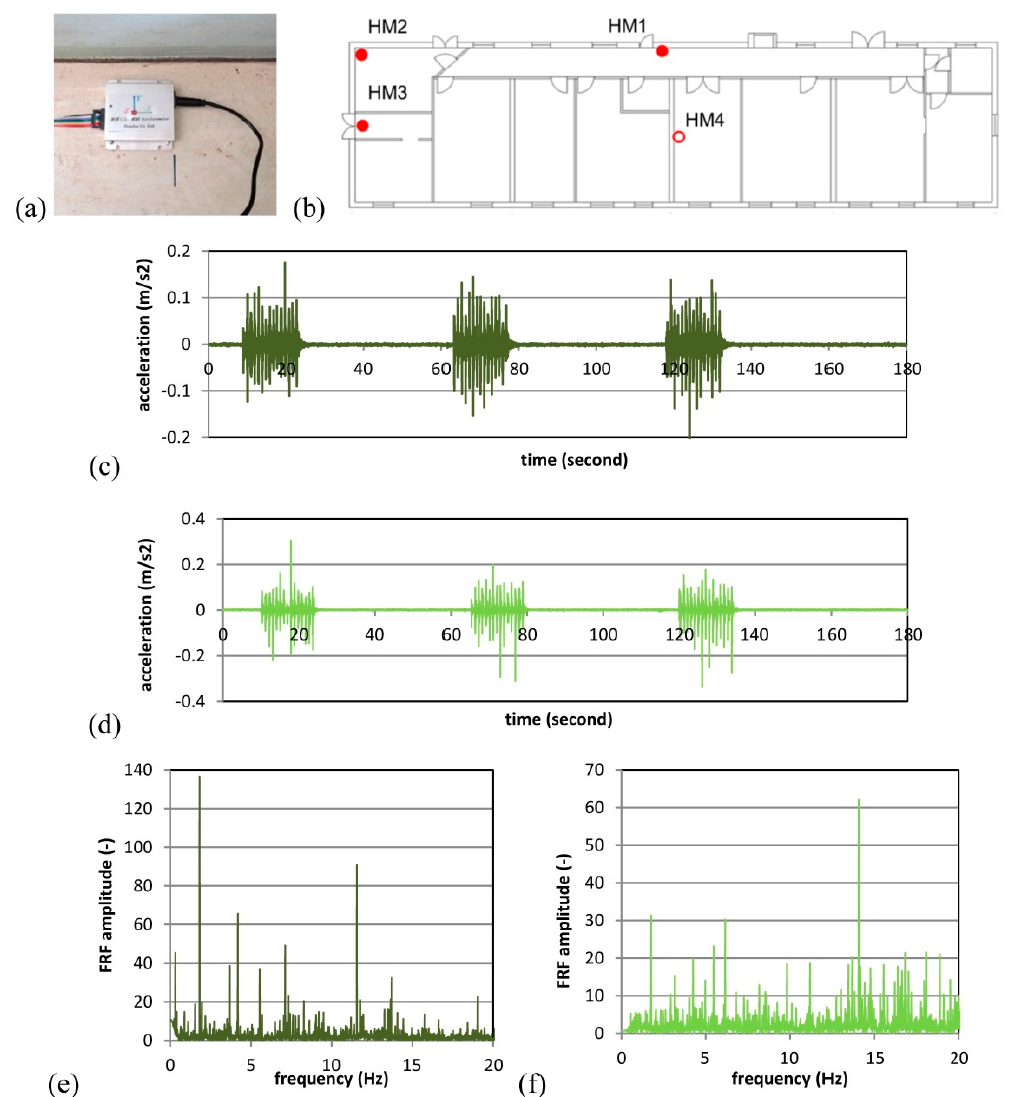
Figure 8. Monitoring of the Matsumoto storehouse: ( a ) instillation of a MEMS sensor, ( b ) locations of sensors, the acceleration time history of the HM1 sensor ( c ) and the HM3 sensor ( d ), frequency response function of HM1/HM4 ( e ) and of HM3/HM4 ( f ).